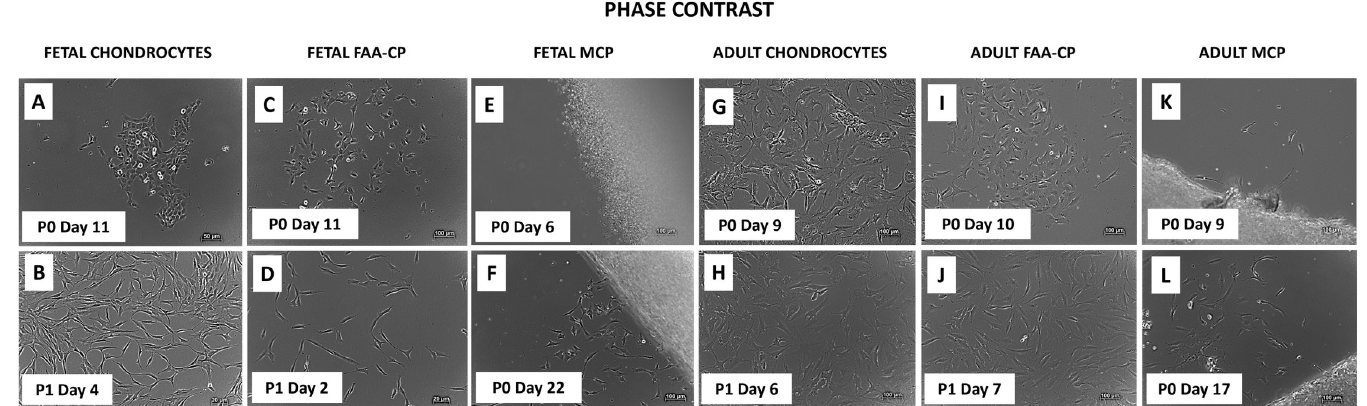
Fig 2. Representative images of Fetal and Adult Chondrocytes, FAA-CPCs and MCPs during monolayer expansion culture. Microscopic analysis observed using phase-contrast microscopy showed that fetal chondrocytes (A) displayed a clonal-shaped cobblestone growth pattern similar to the FAA-CPCs (C, I), with further passage demonstrating a spindle-shape, unlike the fibroblast-like pattern observed with adult chondrocytes(H). Migration of chondroprogenitors from the cartilage explants was seen by the 10th day reaching a confluence of 80% by the third week from both fetal (F) and adult cartilage (L) explants. Magnification 10x.